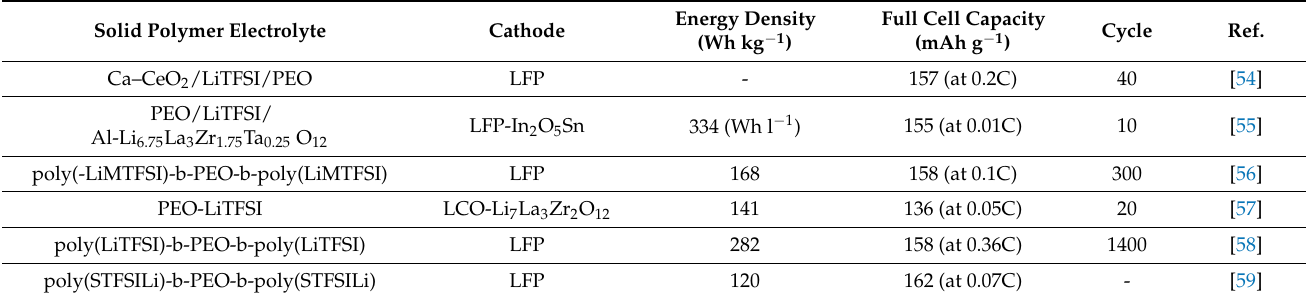
Table 2. Cell characteristics of all-solid state batteries (ASSB) cells prepared with composite polyethylene oxide (PEO) solid